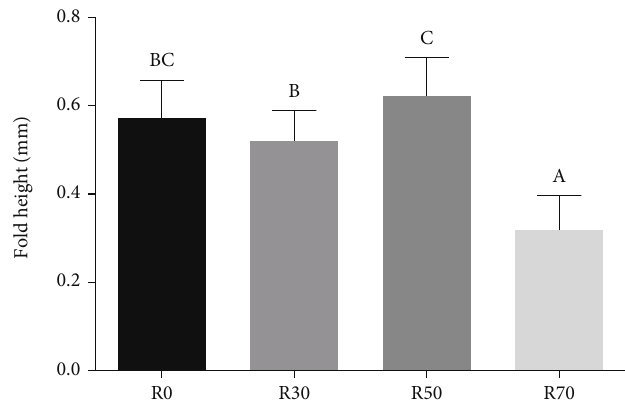
Figure 3: Fold height of hindgut in grass carp fed practical diets (mm) ( means ± SD , n = 10 ). Notes: as above.